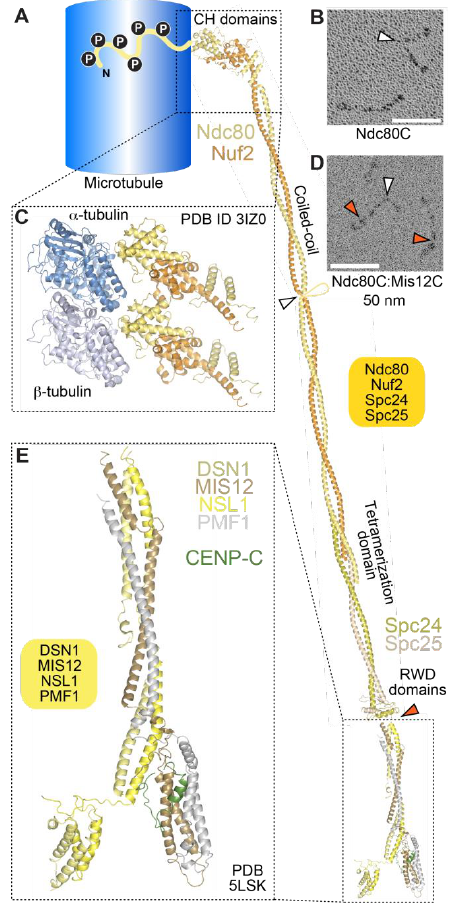
Figure 4. The NDC80 and MIS12 complexes of the KMN network. ( A ) The NDC80 complex is highly elongated and interacts with microtubules via calponin-homology (CH) domains in the N-terminal regions of NDC80 and NUF2. A basic N-terminal tail preceding the NDC80 CH domain (depicted as unstructured) is subject to Aurora kinase phosphorylation ( Ps in black circle s) and regulates microtubule binding. A long coiled-coil, interrupted by a loop ( white arrowhead ) terminates in a tetramerization domain with SPC24 and SPC25. The latter start with coiled-coils and terminate with RWD domains ( red arrowhead ), which interact with the MIS12 complex; ( B ) Rotary shadowing electron microscopy of the NDC80 complex, showing its characteristic dumbbell shape, and an overall length of ~65 nm. Images in ( B , D ) courtesy of Dr. Pim Huis in ‘t Veld, Max Planck Institute of Molecular Physiology, Dortmund (Germany) [239]; ( C ) Model from cryo-EM studies of the Ndc80 Bonsai complex bound to the microtubule lattice. Only a single α -tubulin: β -tubulin dimer is shown, with two Ndc80 Bonsai complexes bound via the toe region; ( D ) Complexes of the NDC80C and MIS12C are ~85 nm in length; ( E ) Structural organization of the MIS12 complex bound to the N-terminal region of CENP-C [241]. All structures shown are for the human